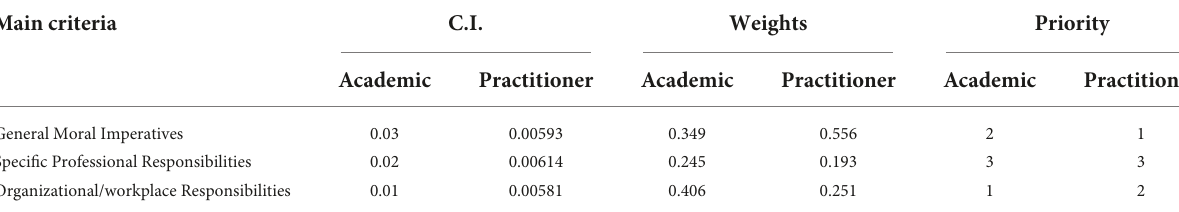
TABLE 5 Three main criteria weights and ranking by experts in the LIS field.